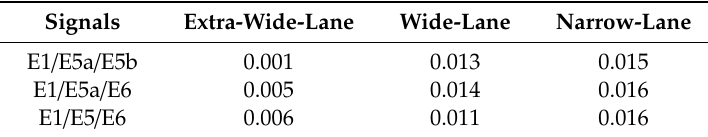
Table 3. Mean STDs (cycles) of extra-wide-lane, wide-lane and narrow-lane phase biases for all Galileo satellites on all